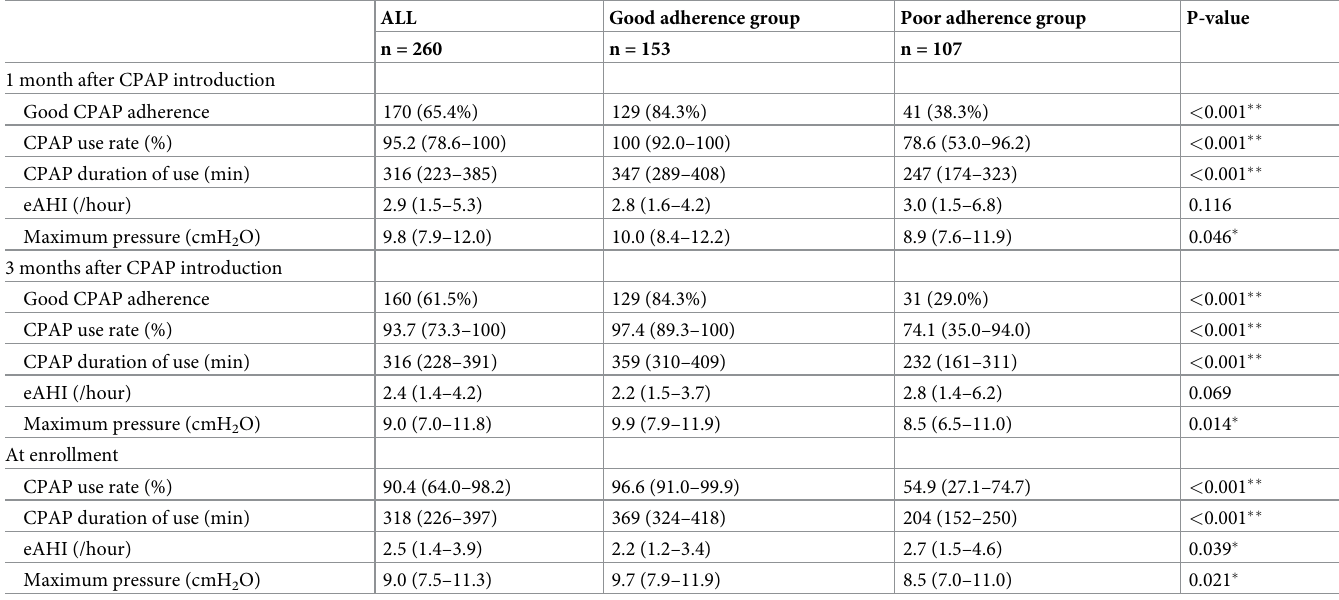
Table 2. Changes in CPAP data at enrollment.